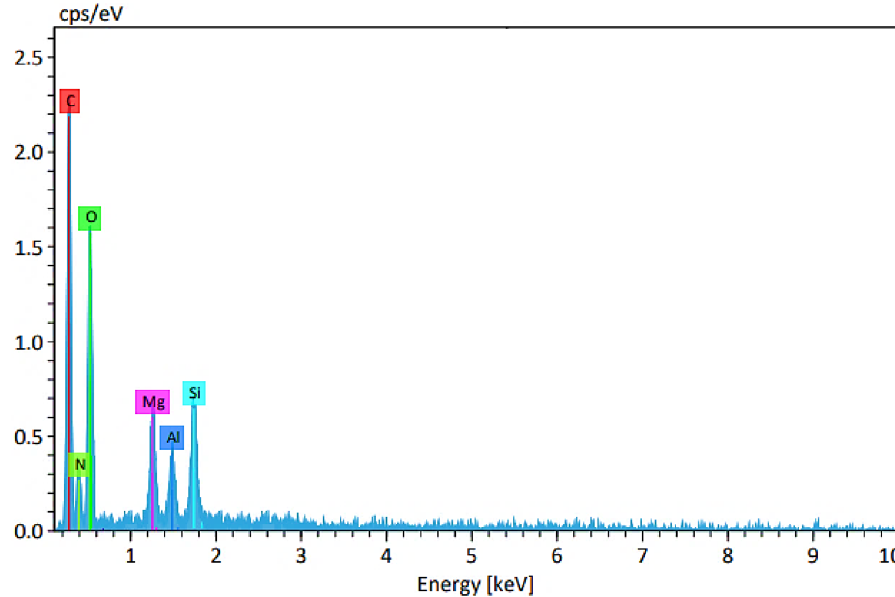
Figure 5. EDX spectra of LDH–APS–PEI–DTPA nanocomposite ( 1 ).